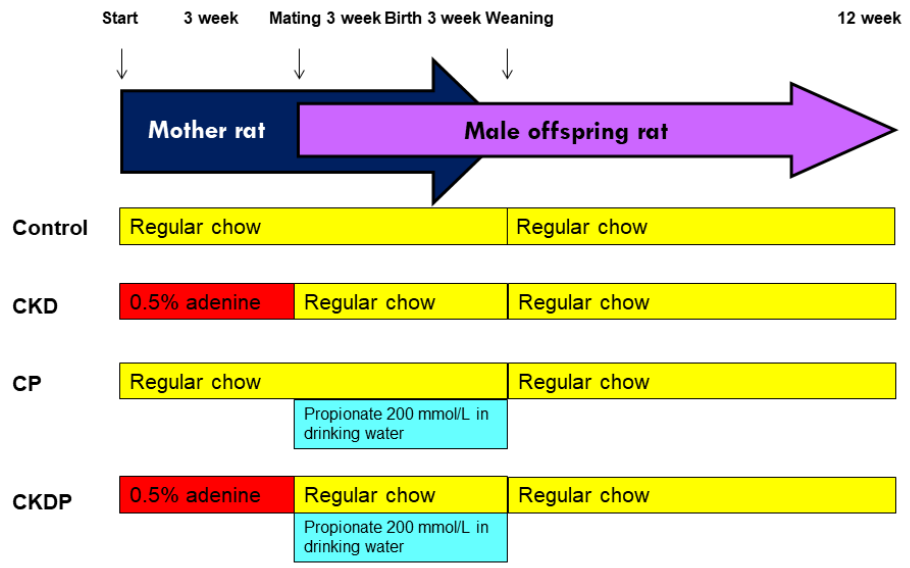
Figure 1. Experimental protocol used in the current study. CKD = adenine-treated rats; CP = control rats received propionate; CKDP = adenine-treated rats received propionate.